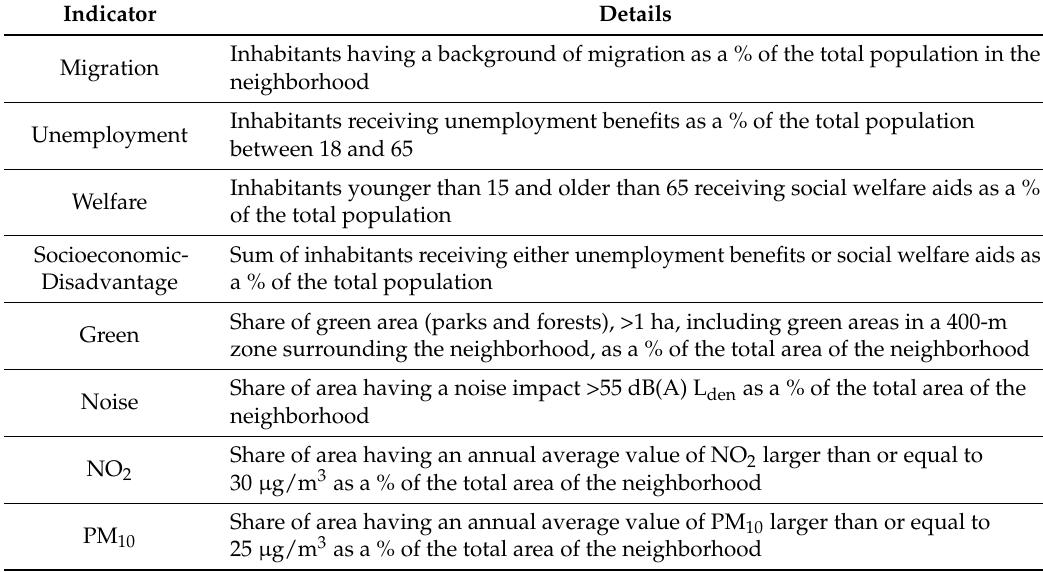
Table 3. Selected